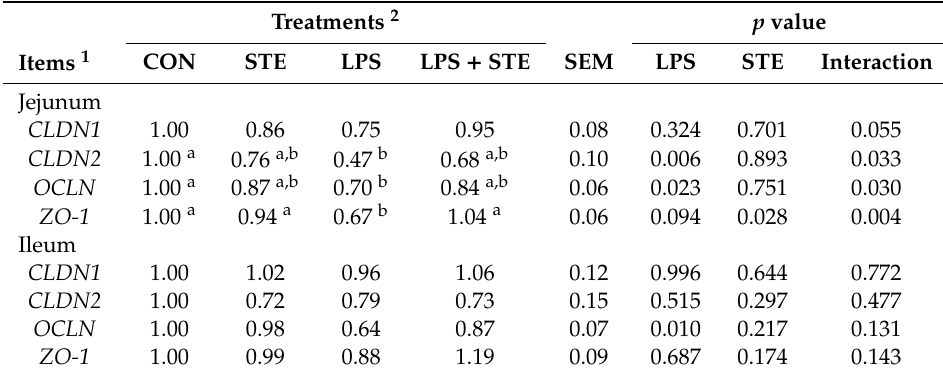
Table 6. E ff ects of stevioside supplementation on tight junction-related genes expression in the intestinal mucosae of LPS-challenged